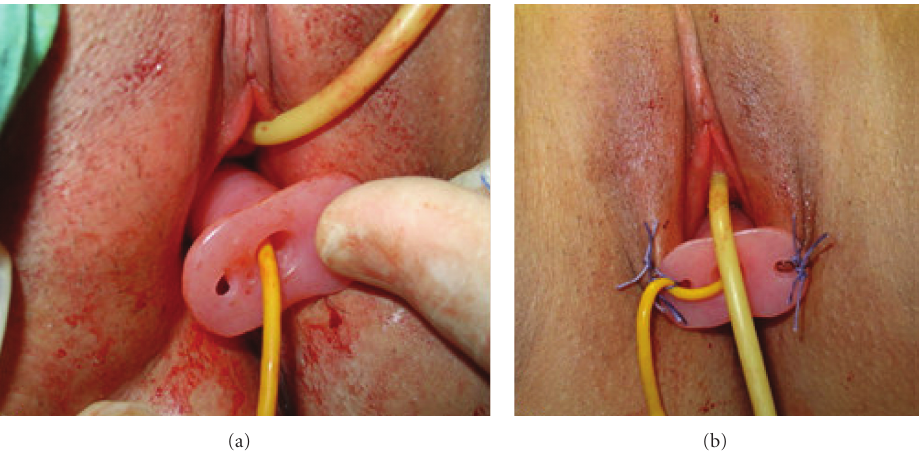
Figure 7: The mold in neovagina (a) and sutures put in between labia majora and the small holes located at the distal end of the mold